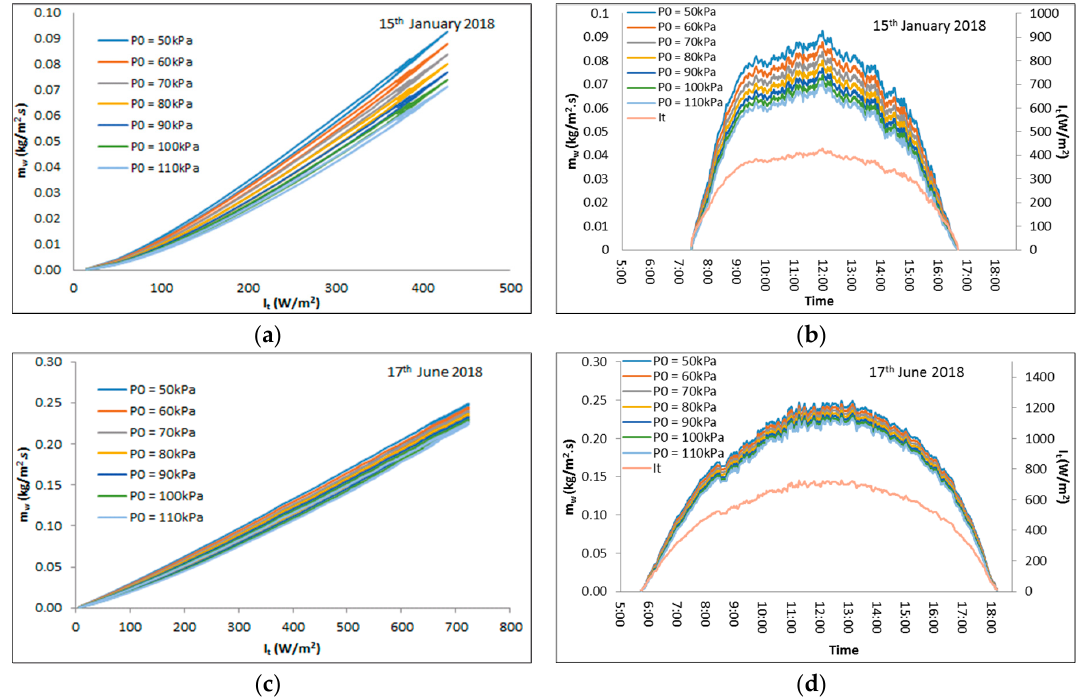
Figure 7. Effect of vacuum pressure on the production of a geothermal solar still. ( a , b ) represent the analysis for a winter’s day on 15 January 2018. ( c , d ) represent the analysis for a summer’s day on 17 June 2018.